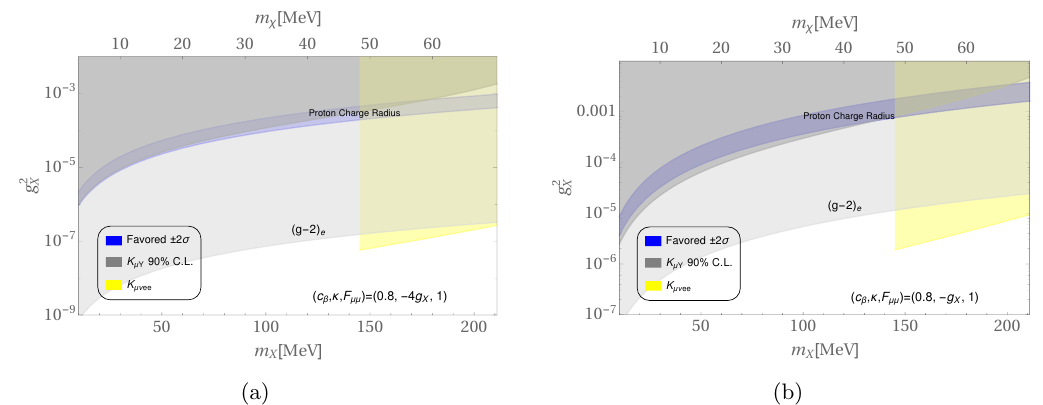
Figure 3 . The allowed region for the proton radius explanation, using the bound in eq. (3.24). Under the narrow-width approximation the vector X (cid:22) decays into the missing (cid:22) (cid:31)(cid:31); (cid:22) (cid:23)(cid:23) pairs. Here m X = 3 m (cid:31) and F (cid:28)(cid:28) = 0. Parameter